Question: Condense the content of this figure into a single sentence.
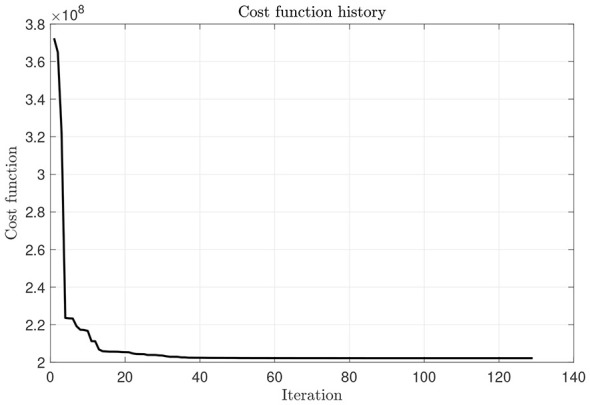
Answer: The value of objective function C for each iteration.